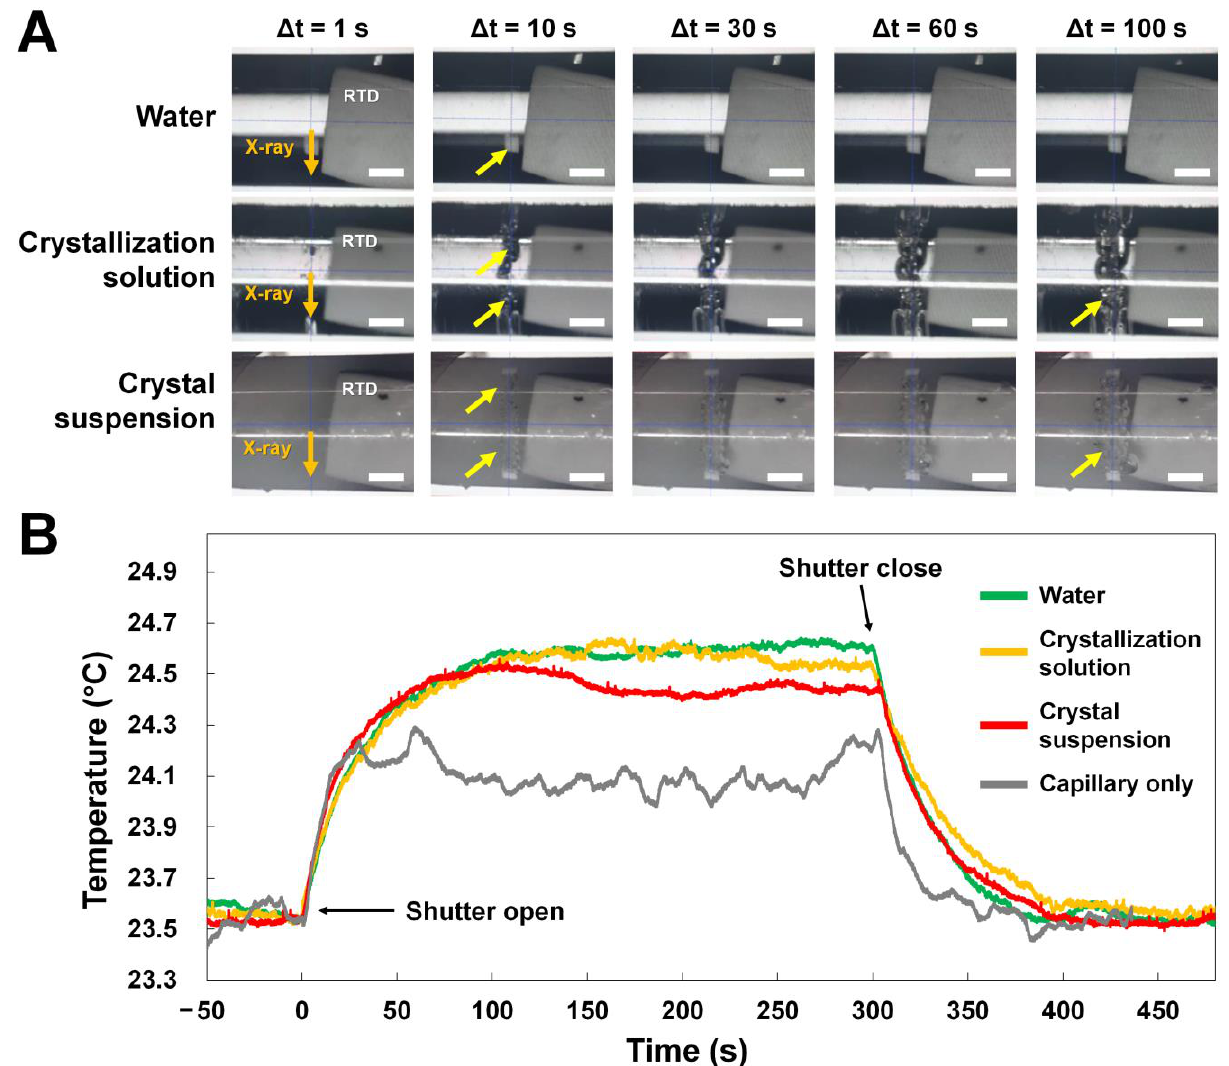
Figure 2. X-ray-induced radiation damage and temperature increase. ( A ) Time-lapse of the radiation damage for water, crystallization solution, and crystal suspension. ( B ) Two-dimensional profile of the temperature rising due to X-ray exposure. The gas bubbles corresponding to the radiation damage are indicated by yellow arrows. Scale bar indicates 250 μm.